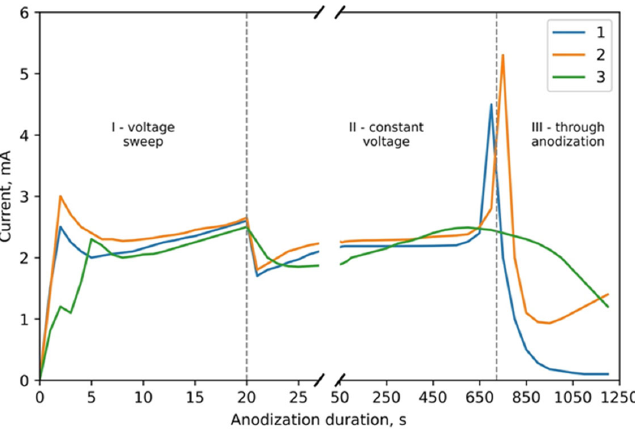
Figure 3. CVA curves of the simultaneous anodic treatment of the two ‐ layer thin ‐ film composition of Al (1000 nm) on Ta (400 nm) for type I samples: 1 —sample No. 1; 2 —sample No. 2; 3 —Al only (1000 nm).